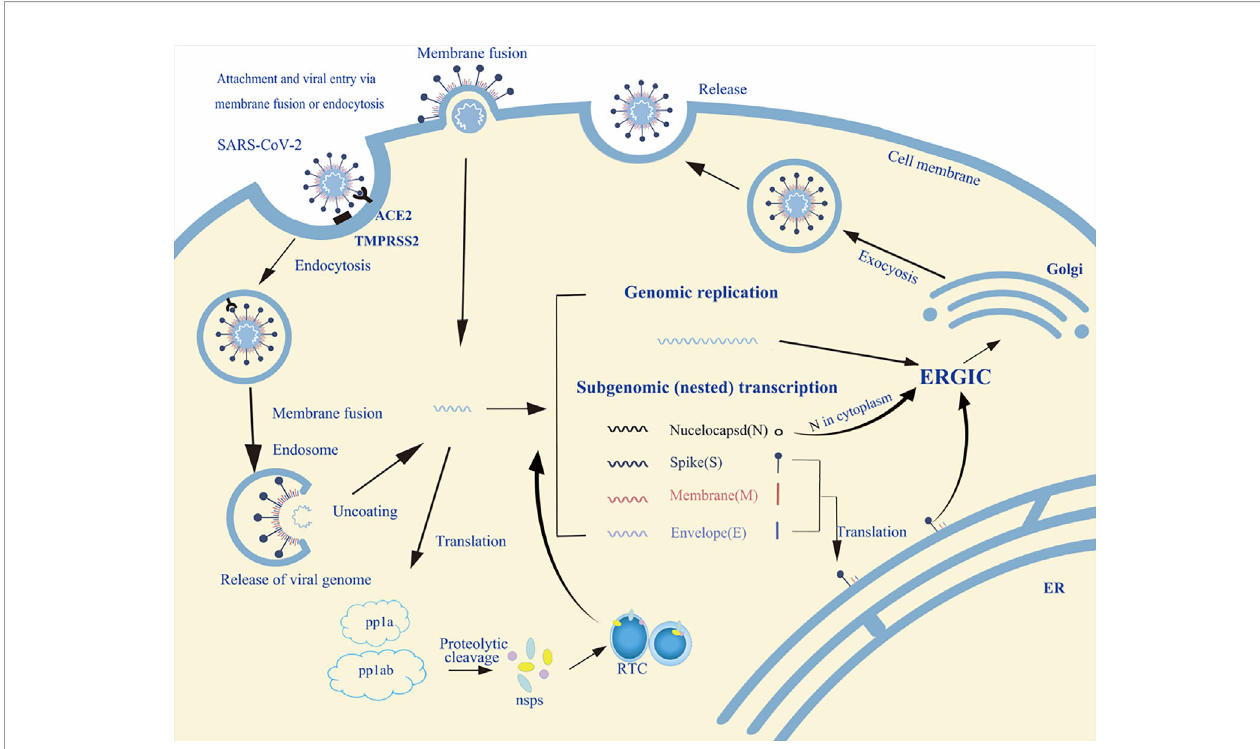
FIGURE 2 | An overview of the life cycle of SARS-CoV-2 in host cells. Spike protein of SARS-CoV-2 binds to the host receptor ACE2 (angiotensin-converting enzyme 2); host factor TMPRSS2 (a cell surface serine protease enzyme), which helps the virion enter the host cells. SARS-CoV-2 enters through membrane fusion or endocytosis. Then it releases RNA to the cytoplasm. Some genomic RNA can be translated into viral proteins as the template, some of these proteins form a replication complex to make more RNA. Viral proteins and genome RNA are subsequently assembled into a new virion in ER and Golgi. Finally, the mature virions are released from the infected cell via exocytosis. The detailed life cycle of SARS-COV2 in host cells is referred to in the following literature (17 – 19). nsps, non-structural proteins; RTC, replication/transcription complex; ER, endoplasmic reticulum; ERGIC, ER-to-Golgi intermediate